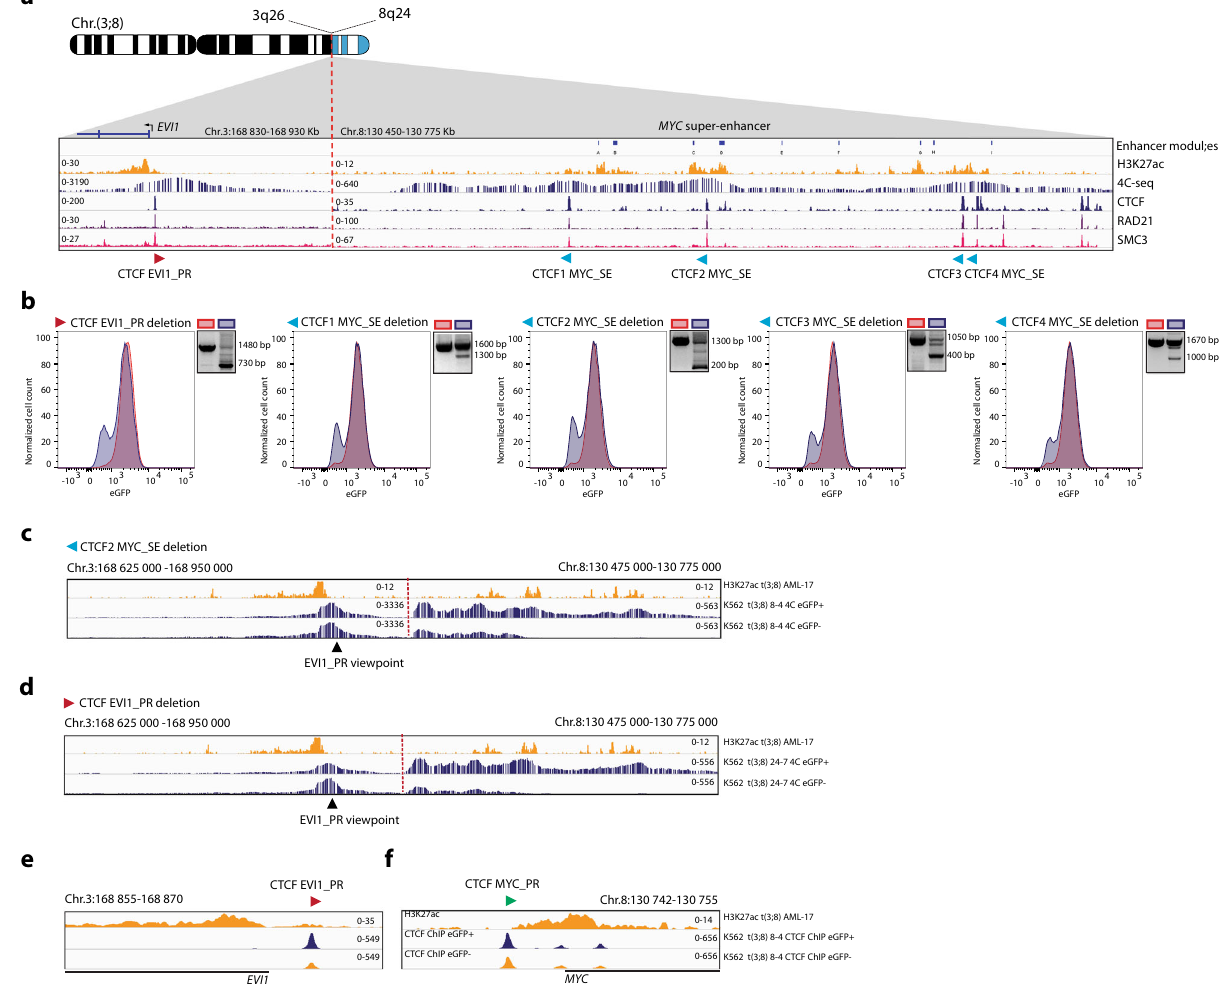
Fig. 5 CTCF binding sites in MYC SE are involved in the interaction with the EVI1 promoter. a Schematic overview of the t(3;8) model, zoom-in on the breakpoint with 3q26 on the left and 8q24 on the right (separated by a dotted red line). The EVI1 promoter and the MYC super-enhancer are illustrated by H3K27ac ChIP-seq data of primary t(3;8) AML (AML-17) in orange on top. Below in blue, 4C-seq data showing the interaction pattern between the EVI1 promoter and the MYC enhancer modules in K562 t(3;8) clone 24-7. The lower 3 tracks show ChIP-seq data of CTCF (blue in K562 t(3;8) clone 24-7) and the cohesin subunits RAD21 (purple) and SMC3 (pink), both in K562 WT and retrieved from ENCODE 62 . b Flow cytometry plot of K562 EVI1-eGFP t(3;8) clone 8-4 cells after deletion of the indicated CTCF binding site (blue graph), and in red the control cells (no Cas9). On the right of the graph, the deletion is shown by PCR. Source data are provided as a Source Data fi le. c Chromatin interaction at the MYC SE in eGFP + (upper blue track) and eGFP − cells (lower blue track), shown by 4C-seq with the EVI1 promoter as viewpoint, after deletion of the MYC SE CTCF2 binding site. The top H3K27ac ChIP-seq track (orange) shows the presence of the active EVI1 promoter and the modules of the MYC SE. d Chromatin interaction at the MYC SE in eGFP + (upper blue track) and eGFP − cells (lower blue track), shown by 4C-seq with the EVI1 promoter as viewpoint after deletion of the EVI1 PR CTCF binding site (indicated by the red arrow, corresponding to the CTCF EVI1 _PR locus in A). The top H3K27ac ChIP-seq track (orange) shows the presence of the active EVI1 promoter and the modules of the MYC SE. e CTCF ChIP-seq presenting CTCF occupancy in eGFP − cells (clone 8-4, orange) compared to eGFP + cells (clone 8-4, blue) at the CTCF binding site upstream of the EVI1 promoter after deletion of this CTCF EVI1 _PR site. The top H3K27ac ChIP-seq track (orange) shows the presence of the active EVI1 promoter and the modules of the MYC SE. f The same CTCF ChIP-seq tracks are shown (clone 8-4), but now presenting unchanged CTCF occupancy at the CTCF binding site upstream of the MYC